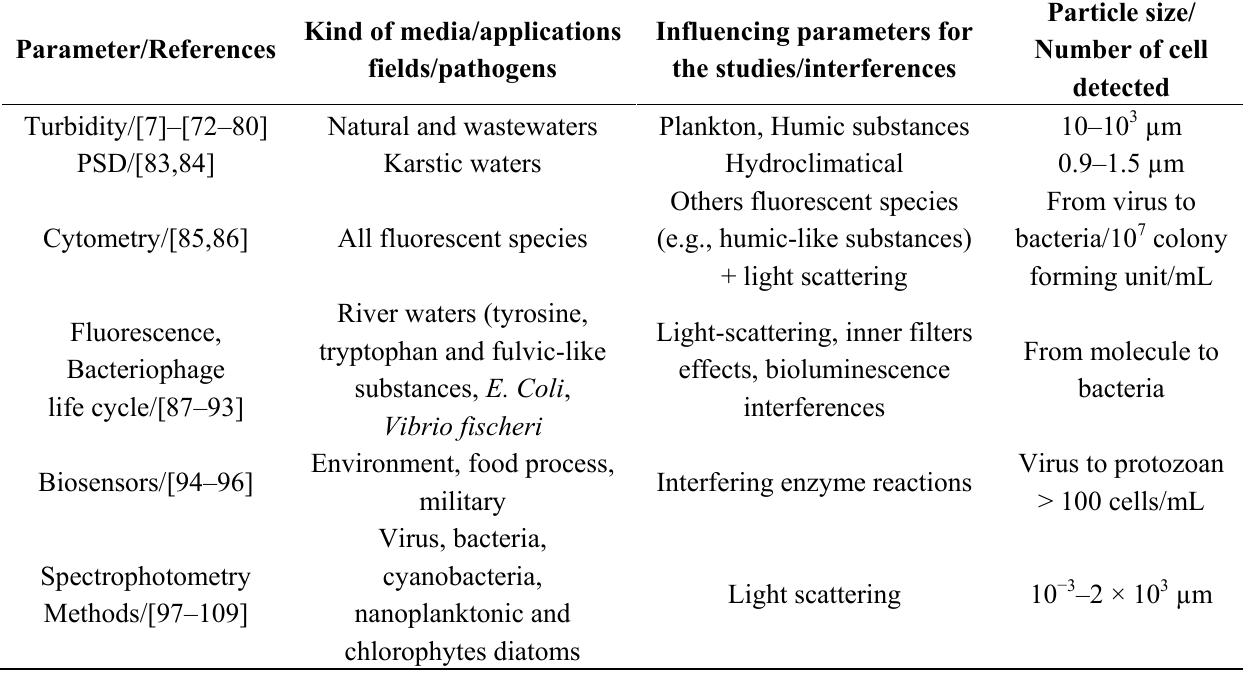
Table 3. Synthesis of classical and trends in optical methods for pathogens